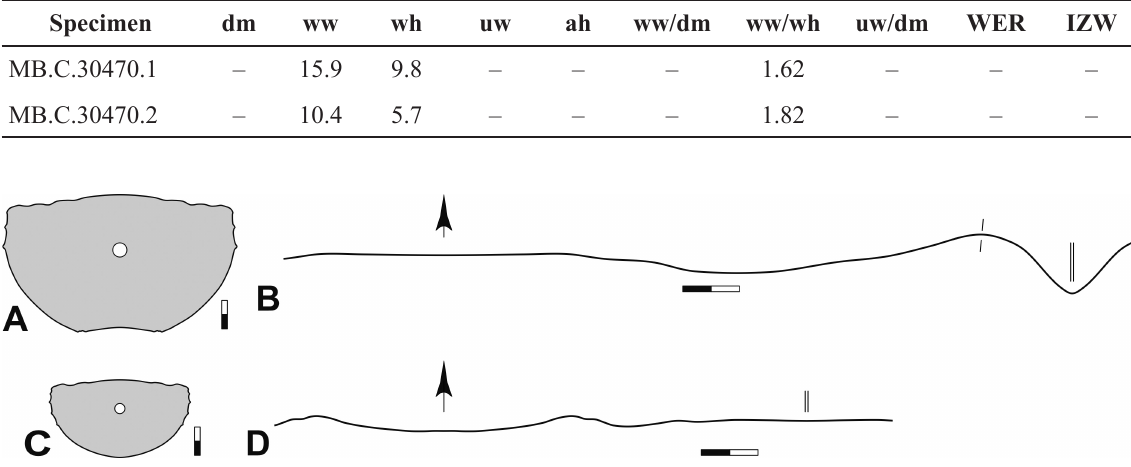
Fig. 17. Vestinautilus papilio sp. nov. from Oued Temertasset (both Korn et al . 2002 Coll.). A . Whorl profile of holotype MB.C.30470.1. B . Suture line of holotype MB.C.30470.1, at ww = 15.5 mm, wh = 9.5 mm. C . Whorl profile of paratype MB.C.30470.2. D . Suture line of paratype MB.C.30470.2, at ww = 10.3 mm, wh = 5.6 mm. Scale bar units = 1